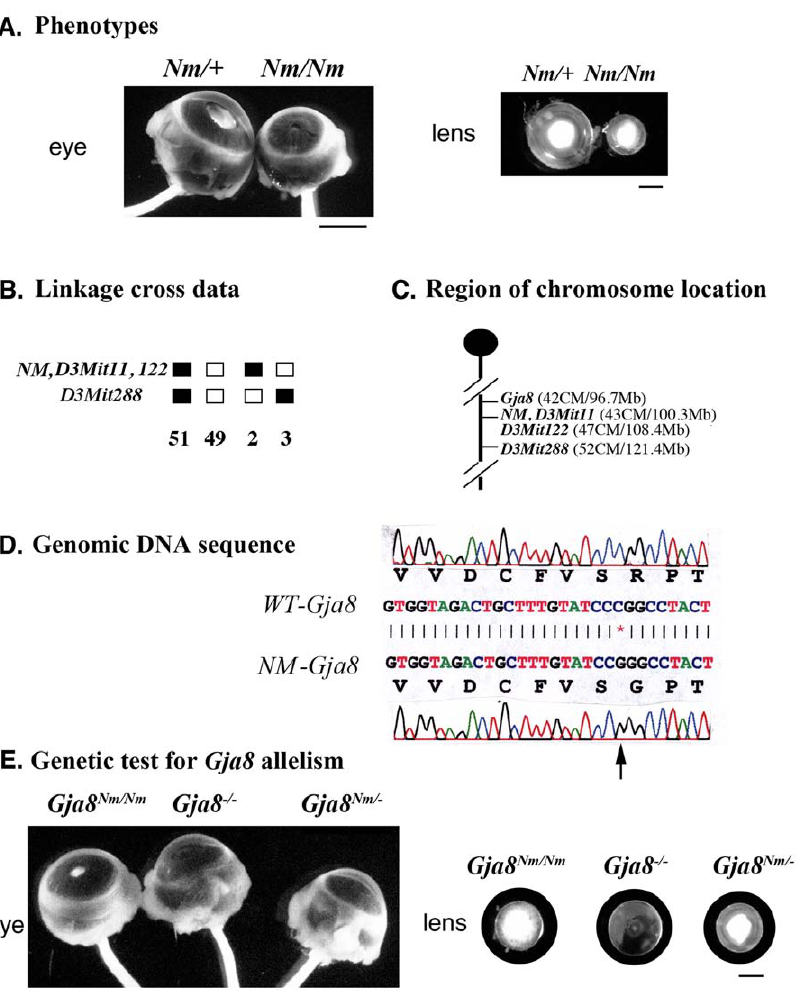
Figure 1. Identification of the Gja8 R205G mutation in Nm2249 mice. ( A ) Photos of eyes and lenses of Nm2249 heterozygous ( Nm/ + ) and Nm2249 homozygous ( Nm/Nm ) mutant mice in the CWXS/Agl strain background at the age of 3 weeks. Scale bars, 1 mm. ( B ) Genome-wide screening data of the phenotypes and genotypes of 105 backcrossed mice, generated between mutant Nm2249 and wild-type CAST/Ei mice. The Nm2249 mutation was mapped to a region near D3Mit11 and D3Mit122 on chromosome 3. ( C ) The Gja8 gene is near the region where the Nm2249 mutation was mapped. ( D ) DNA sequencing data confirmed a missense mutation (C to G) in the Gja8 gene of Nm2249 mutant ( Nm-Gja8 ), which resulted in the arginine at codon 205 of wild-type Gja8 ( WT-Gja8 ) being replaced by a glycine (R205G). ( E ) Homozygous Gja8 Nm2249/Nm2249 mutant mice were bred with the Gja8 2 / 2 knockout mice for a Gja8 allelic test. Phenotypic comparison of eyes and lenses of Gja8 Nm2249/Nm2249 , Gja8 Nm2249/ 2 and Gja8 2 / 2 mice at the age of 3 weeks was shown. The similarity of small lens size in these mutant mice further indicated that Gja8 R205G is the causative mutation in Nm2249 mice. Scale bars, 1 mm.